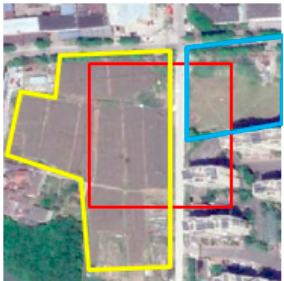
Figure 24. Large-scale image of the sample. The red box represents the sample in Figure 23, city_grass (in blue box) is misclassified as flat_field (in yellow box) by Cluster-GCN, and City_grass and flat_field are ‘different objects with similar spectrum’.